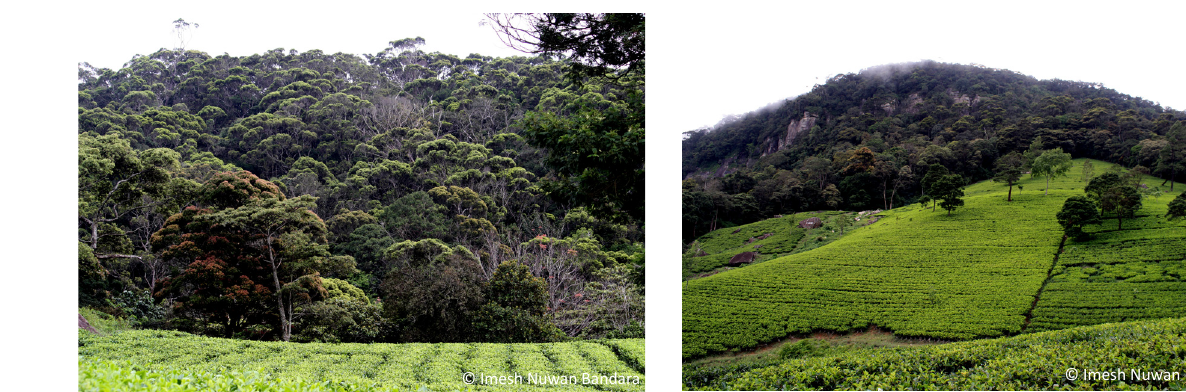
Image 8. Tea plantations at the edge of a forest patch. Image 9. Unreachable areas of pristine forests surrounded by tea plantations.